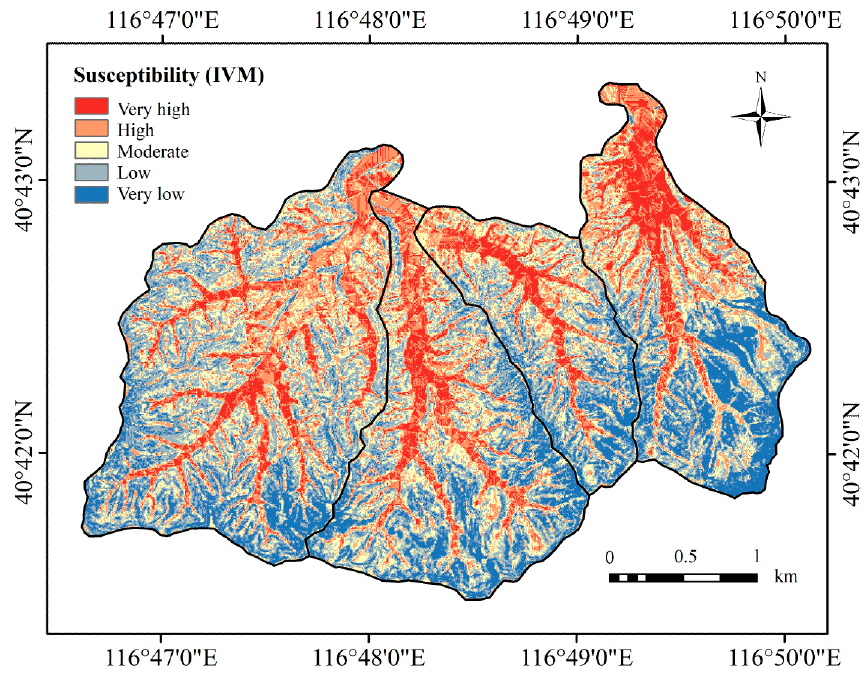
Figure 8. Mass-wasting susceptibility map generated by using the information value model. Table 3. Mass-wasting susceptibility mapping results in the study area.